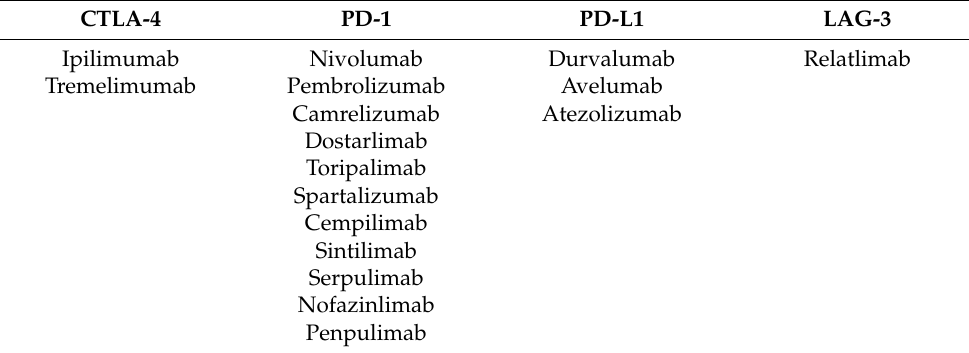
Table 1. Immune checkpoint inhibitors classified according to their main targets.